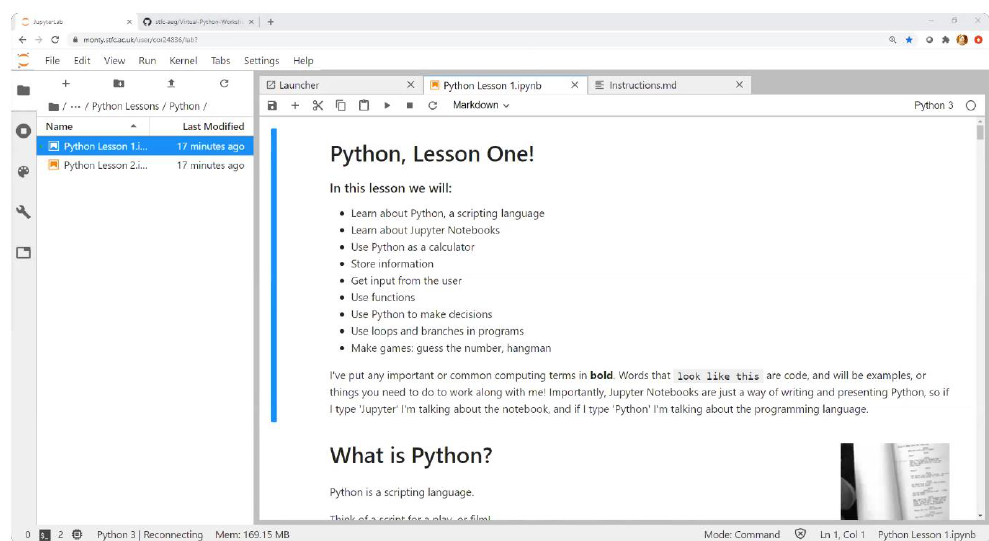
Fig. 5. The python workshop content as a Jupyter